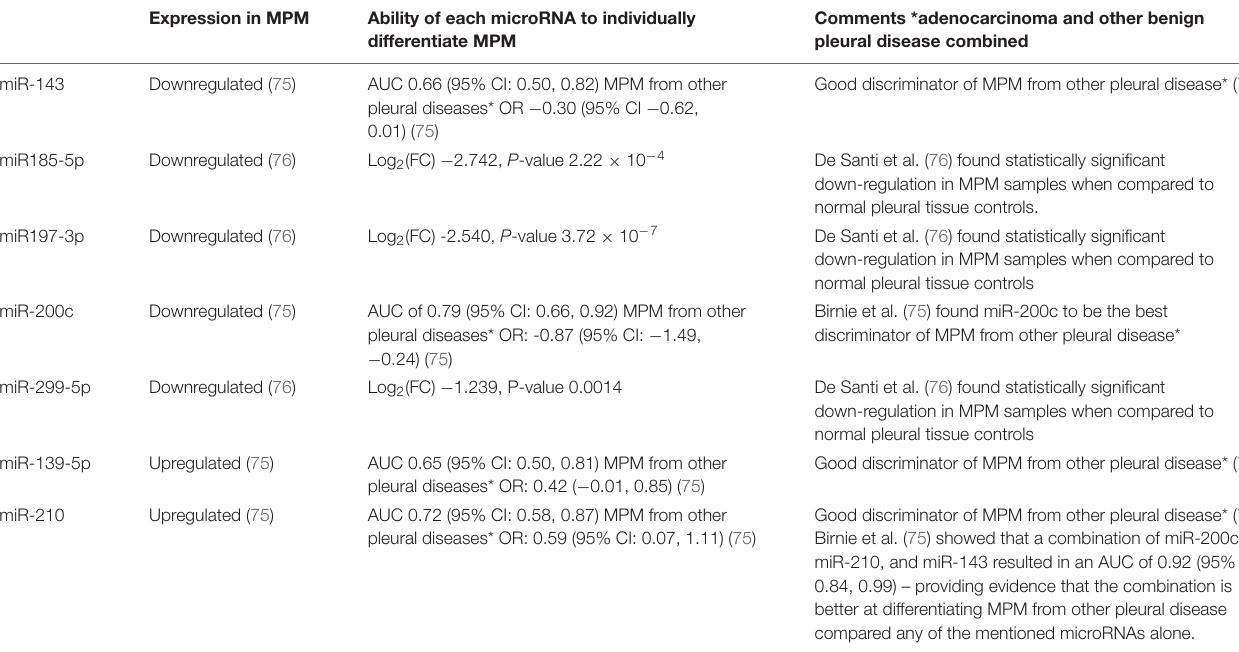
TABLE 6 | Examples of miRNAs in MPM – from studies involving FFPE/frozen tissue